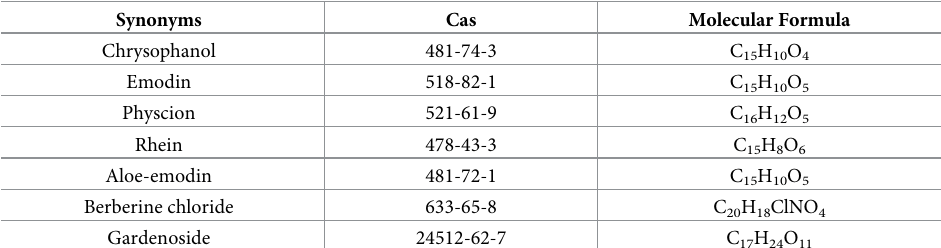
Table 1. Chemical structures of 7 major compounds of San-Huang-Chai-Zhu formula